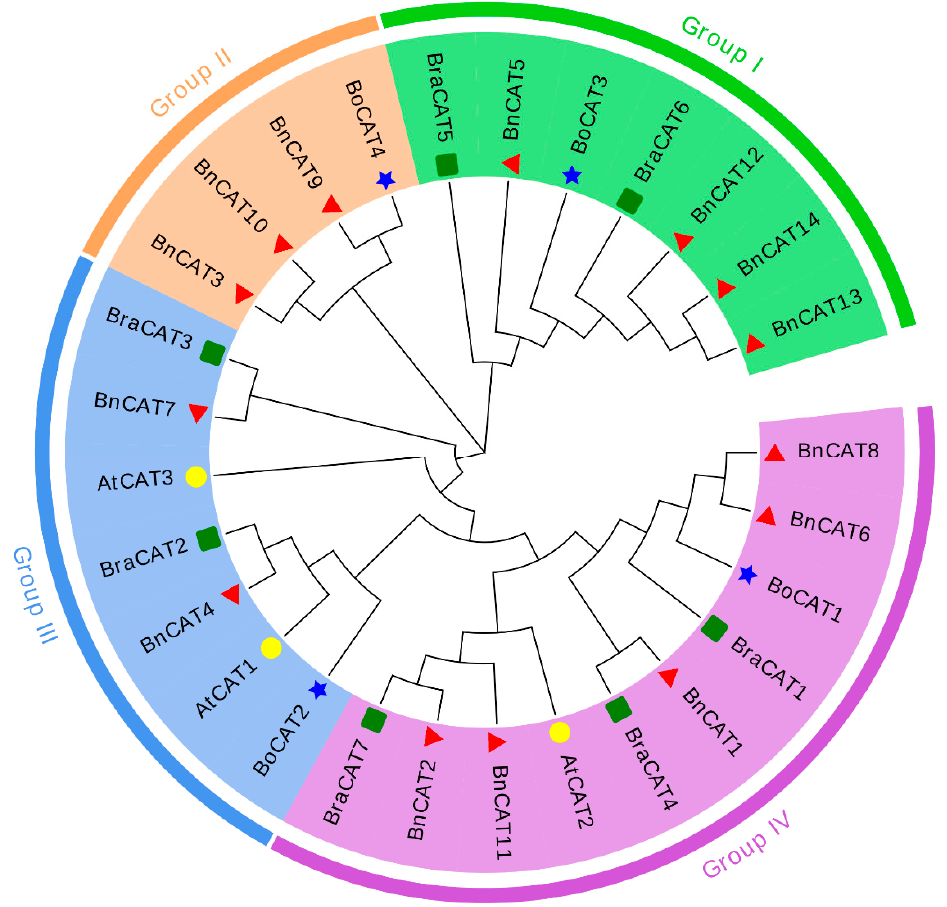
Figure 1. A neighbor-joining phylogenetic tree analysis of CAT proteins in Brassica napus, Brassica oleracea, Brassica rapa, and Arabidopsis thaliana . Overall, 14 BnCATs from Brassica napus (red triangle), 4 BoCATs from Brassica oleracea (blue star), 7 BraCATs from Brassica rapa (green box), and 3 AtCATs from Arabidopsis thaliana (yellow circles) were clustered into four groups (Groups I–IV), represented by different colors.